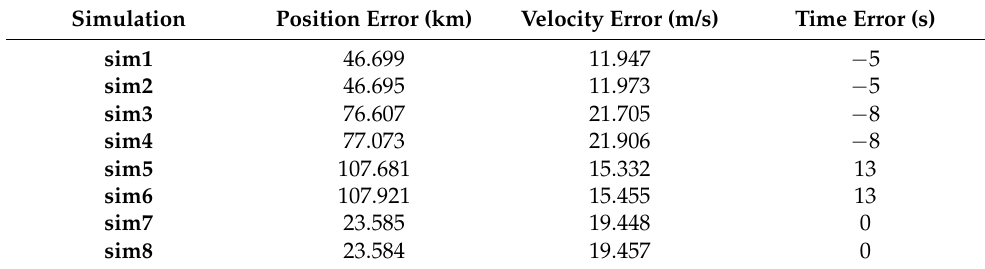
Table 5. Robustness analysis: ECEF tracking error at altitude H = 30 km.